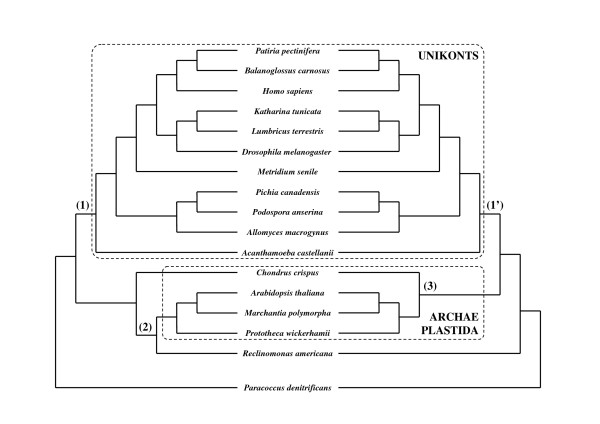
Phylogenetic trees obtained from a non-trimmed character supermatrix (left) and from the concatenation of the multiple sequence alignments trimmed by BMGE with BLOSUM95 (right). These ML trees were inferred by PhyML with the model mtREV+Γ8+I. Note that the left topology was also inferred from character supermatrices built by concatenating multiple sequence alignments trimmed by BMGE (BLOSUM30 and BLOSUM62), Gblocks (relaxed), trimAl (strictplus and automated1), and Noisy. Bootstap-based and aLRT-based confidence values at nodes (1), (1'), (2) and (3) are given in Table 6.